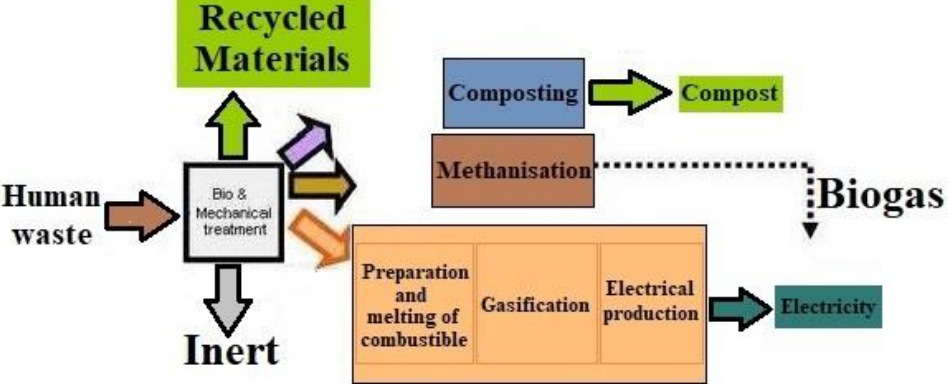
Figure 4. Modern methods for human waste